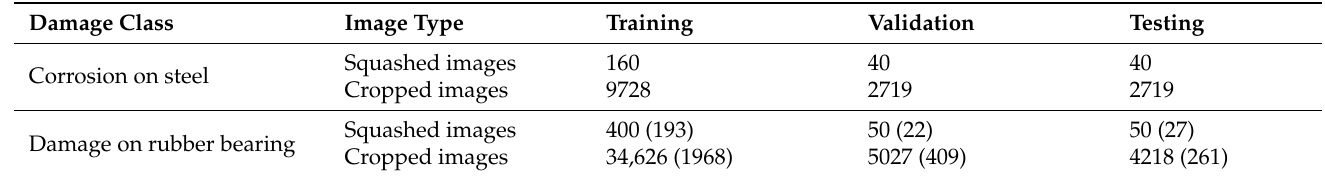
Table 2. The proportion of data set after dropping background